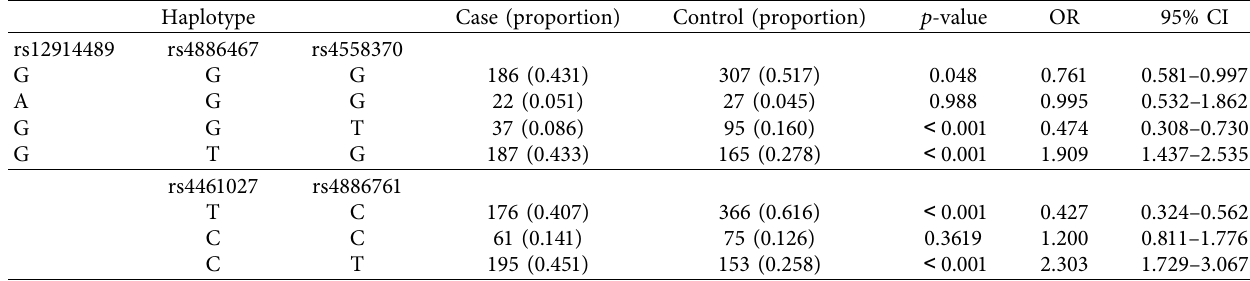
Table 6: The haplotype association analysis between these